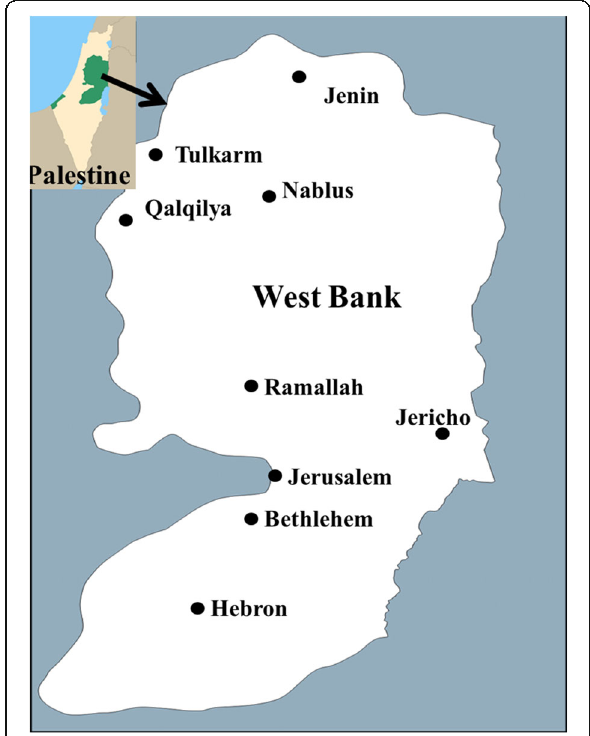
Fig. 1 Map of the West Bank/ Palestine showing all surveyed